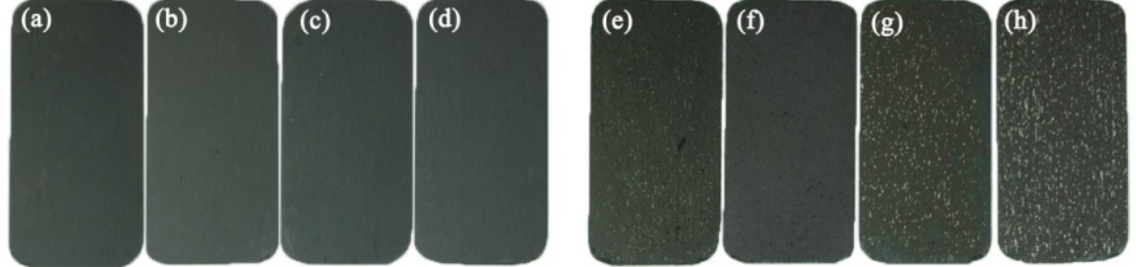
Figure 2. Macroscopic morphologies of the E7, E71, E73 and E75 alloys after isothermal oxidation at 1000 °C. ( a ) E7—4h. ( b ) E71—4h. ( c ) E73—4h. ( d ) E75—4h. ( e ) E7—500h. ( f ) E71—500h. ( g ) E73—500h. ( h ) E75—500h.